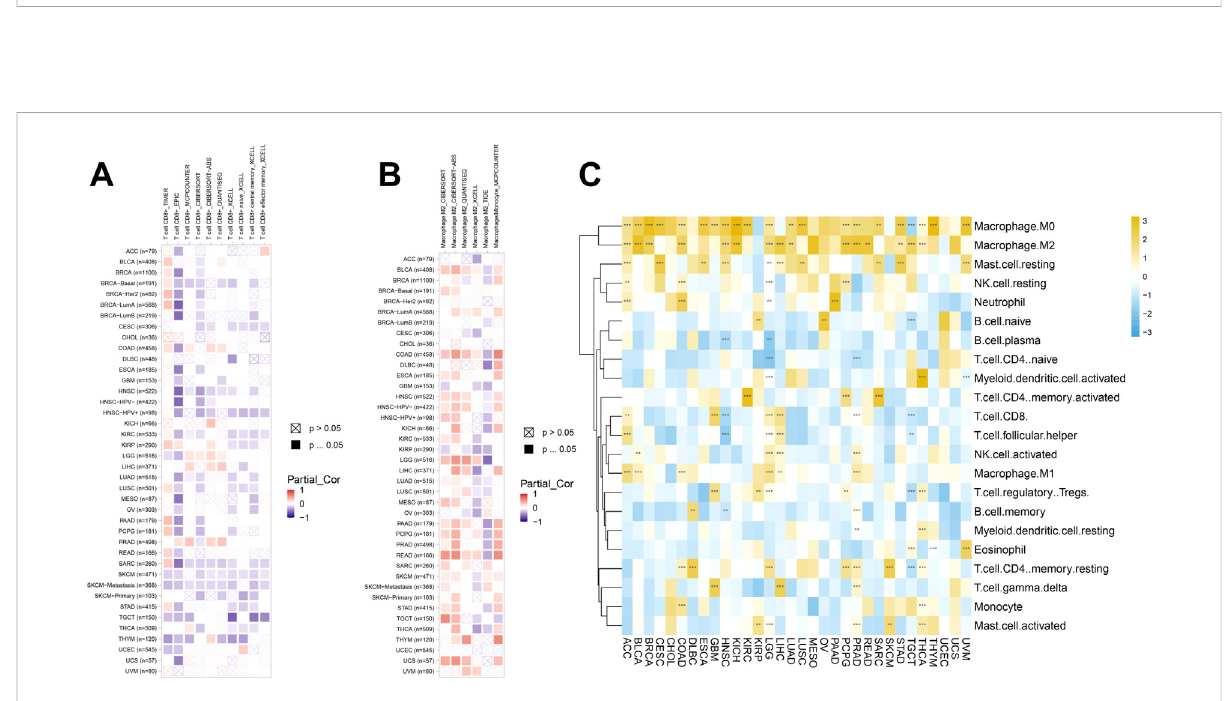
FIGURE 10 Immune cell in fi ltration analyses. (A) Association between SERPINH1 and in fi ltration level of CD8+ T cells. (B) Association between SERPINH1andin fi ltrationlevelofmacrophageM2. (C) AssociationbetweenSERPINH1andin fi ltrationlevelofindicatedimmunecells.* p < 0.05;** p < 0.01; *** p < 0.001, and **** p < 0.0001.